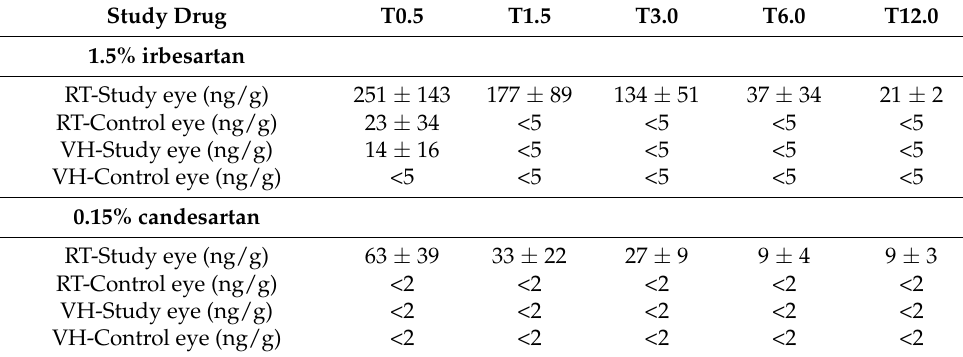
Table 2. Retinal tissue (RT) and vitreous humor (VH) concentrations of irbesartan and candesartan at each time point in the study and the control eye. Data are shown as means ± SD in ng/g. Study Drug T0.5 T1.5